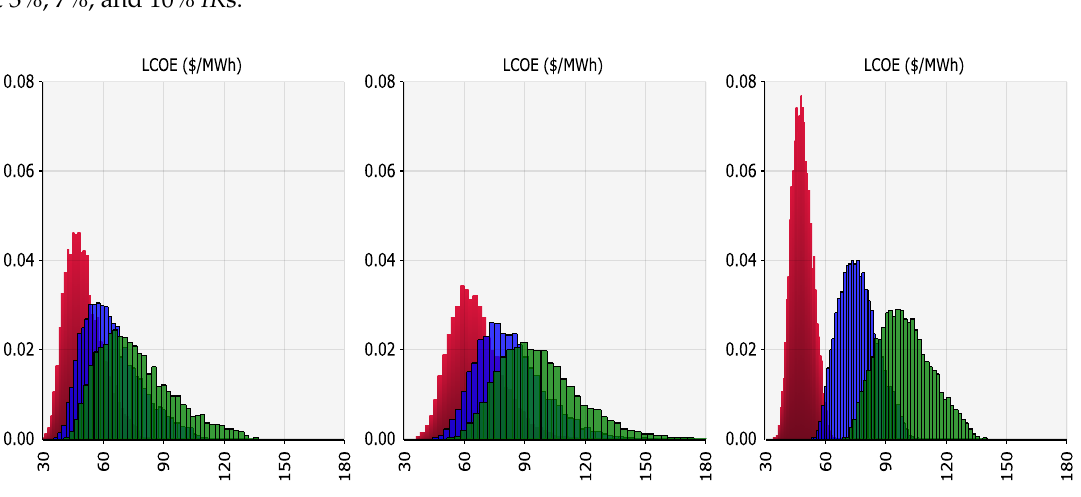
Figure 1. LCOE distributions of Coal ( left ), Wind ( middle ), and Nuclear ( right ) at 3%, 7% and 10% IR. Red represents the LCOE distributions at the 3% IR , blue represents it at the 7% rate, and green does at the 10% rate. It is clear that the LCOE values with the 3% IR are the smallest, as they are located on the left side in each graph. When the three energy sources are compared, coal appears to be the most competitive in overall, in that the graphs generally are skewed to the left compared to those in the wind and nuclear. In fact, the LCOE value of coal at 7% IR is the lowest, with 61.76$ / MWh median LCOE value. As for 3% IR , coal also has high-cost competitiveness along with nuclear power